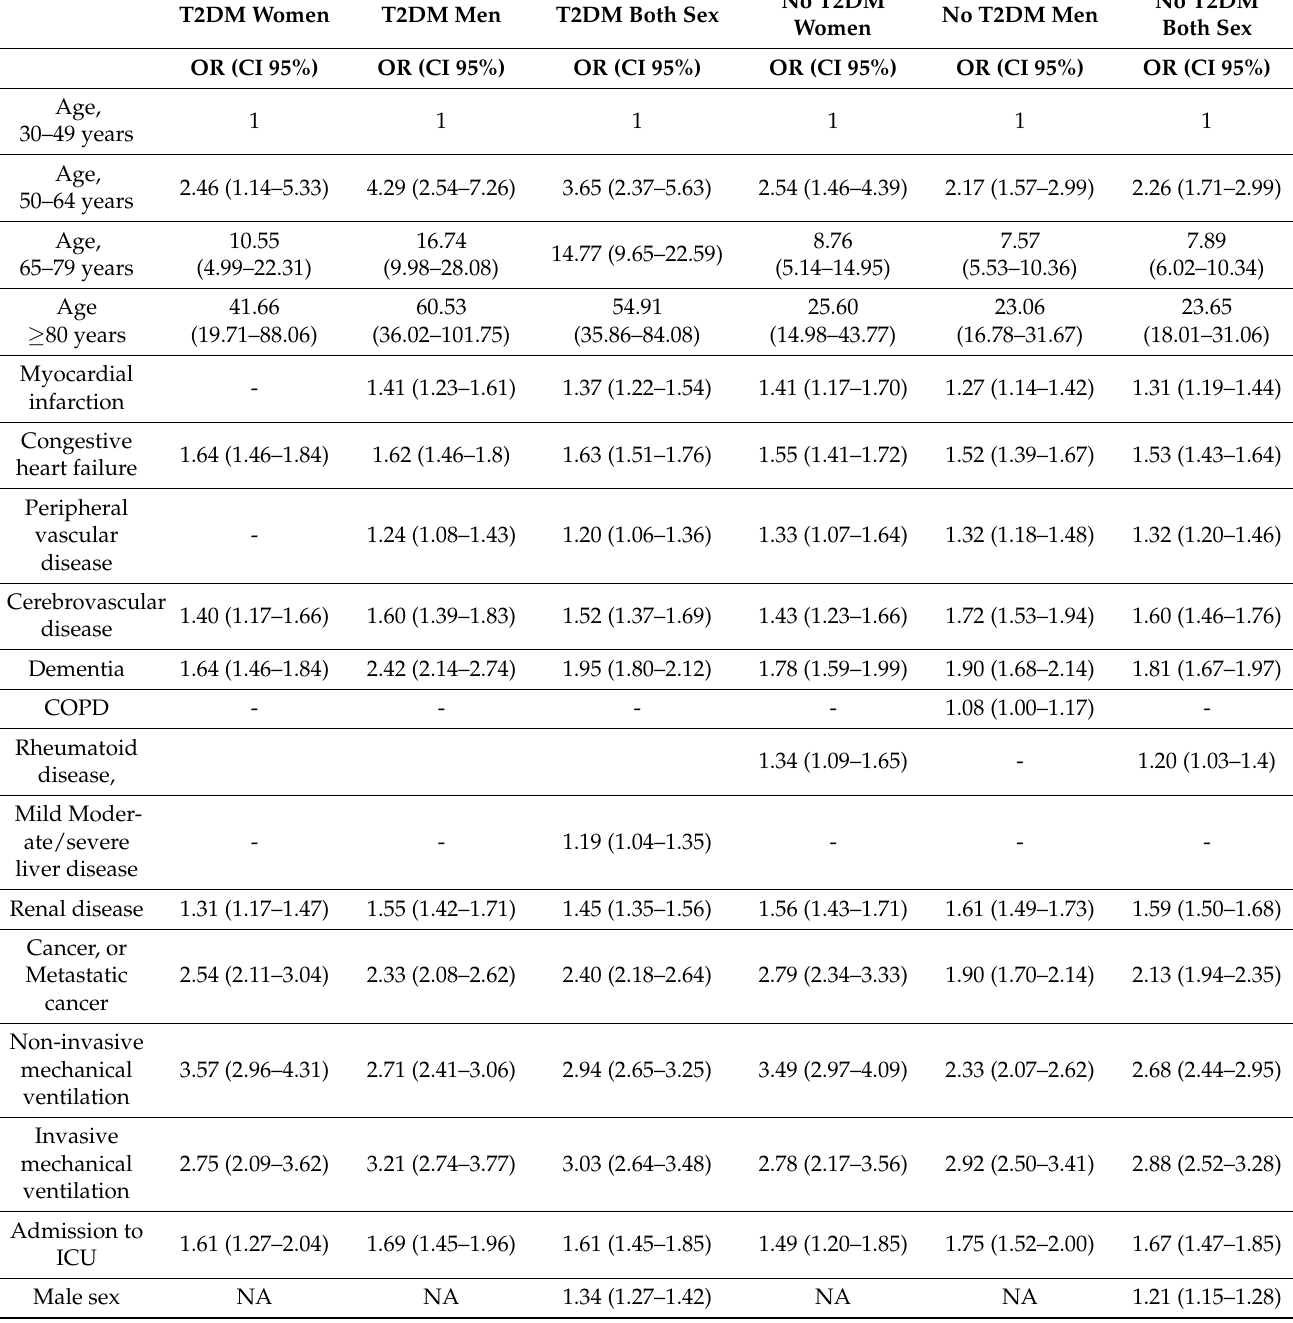
Table 5. Multivariable analysis of variables associated with in-hospital mortality in patients hospital- ized with COVID-19 in Spain, 2020, according to sex and T2DM